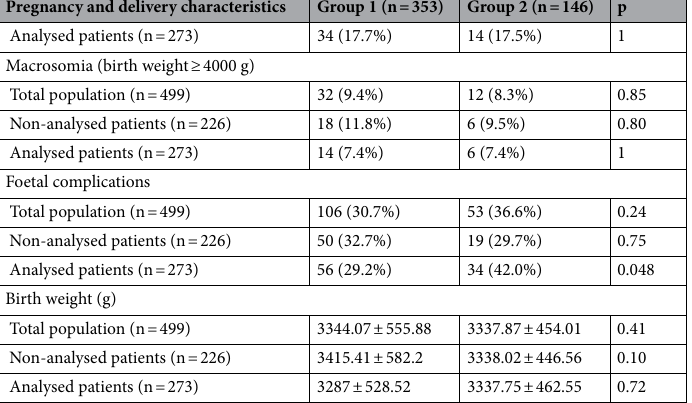
Table 3. Pregnancy and delivery characteristics and obstetrical outcomes. Statistically significant p values between groups are given in bold. Data are presented as number (%) or average ± standard deviation. *p < 0.05 for the comparison between Non-analysed and Analysed